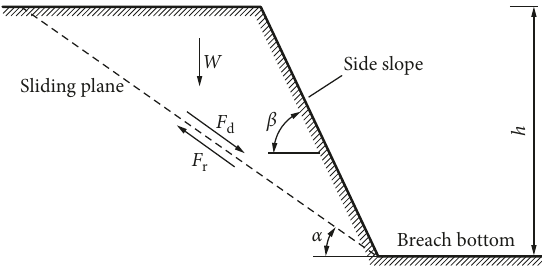
� 2. (b) n � 1. loc loc